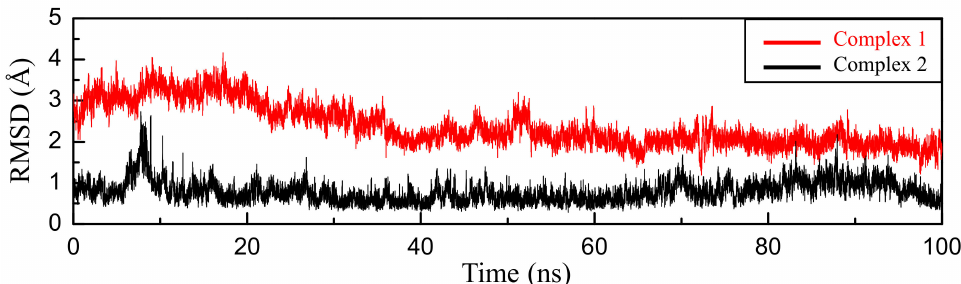
Figure 3. RMSD (Å) plot of substrate 5-HIU during 100 ns simulations, the final ligand conformation from complex 2 was used as the reference, the RMSD of complex 1 is marked with red and the complex 2 is black.